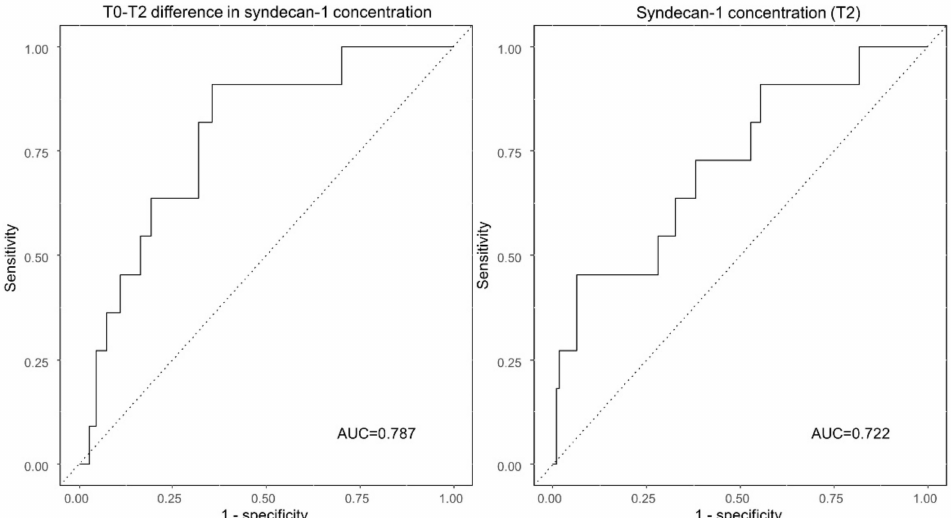
Figure 2. The AUCs for predicting early postoperative complications based on perioperative changes in syndecan-1 concentrations. The AUC for the T0-T2 difference in serum syndecan-1 concentrations is 0.787 (95% CI: 0.663–0.911). In contrast, the AUC for the syndecan-1 concentration at T2 is 0.722 (95% CI: 0.561–0.884). AUC, area under the curve; CI, confidence interval; T0, preoperative baseline; T2, 2 h